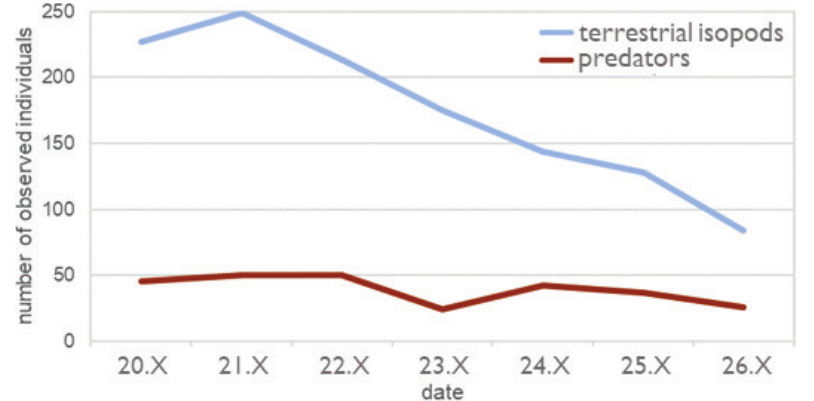
Figure 3. Number of invertebrates recorded per day on the wall during a 90-min observation during October